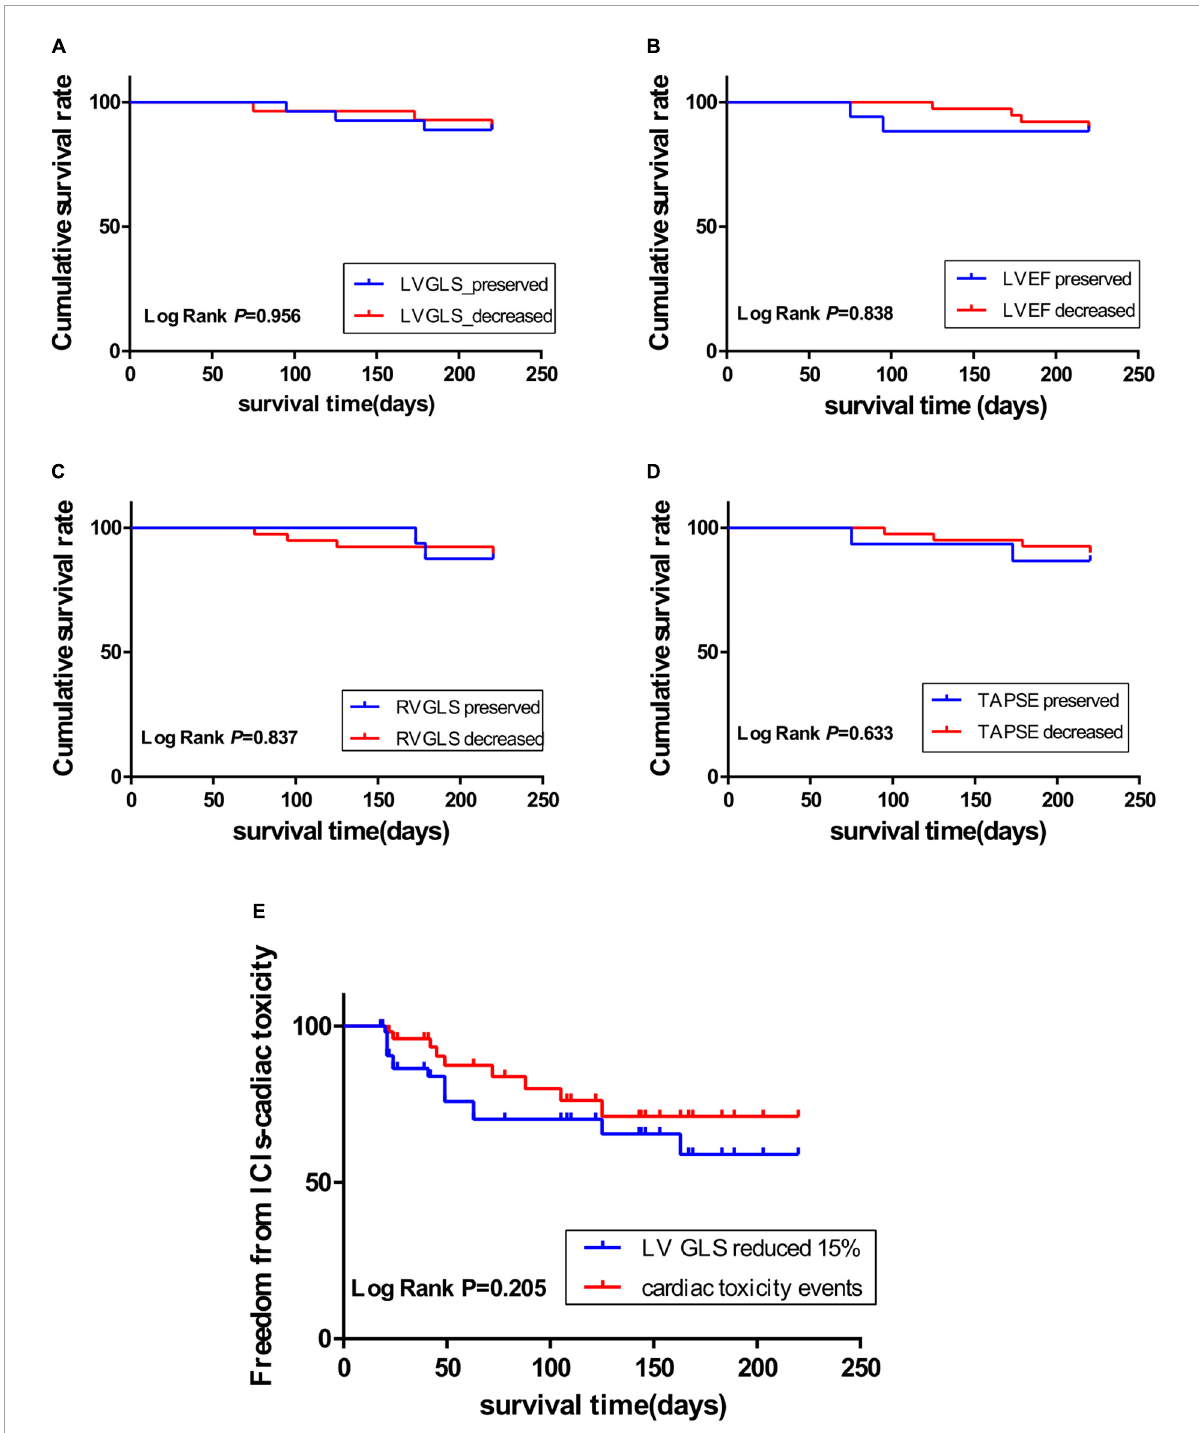
FIGURE2 Kaplan–Meier curve showing the cumulative survival rate according to decreased or preserved left ventricular global longitudinal peak systolic strain (LVGLS), left ventricular ejection fraction (LVEF), right ventricular global longitudinal systolic strain (RVGLS), and tricuspid annular plane systolic excursion (TAPSE); (A) : LVGLS; (B) : LVEF; (C) : RVGLS; (D) : TAPSE. (E) : Kaplan–Meier curve showing the immune checkpoint inhibitor (ICI)-related cardiotoxicity survival time through LVGLS reduced by more than 15% (blue curve), and events (red curve) including heart failure symptoms, troponin increased exceeding the normal range, and LVEF reduced by more than 10% and less than